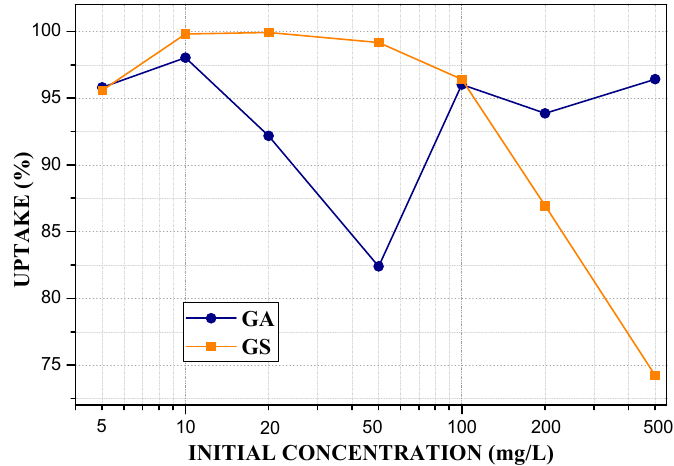
Figure 9. Influence of pH on geopolymers adsorption capacity of Pb 2+ : m = 0.15g, V = 40mL, C 0 = 5 mg/L.